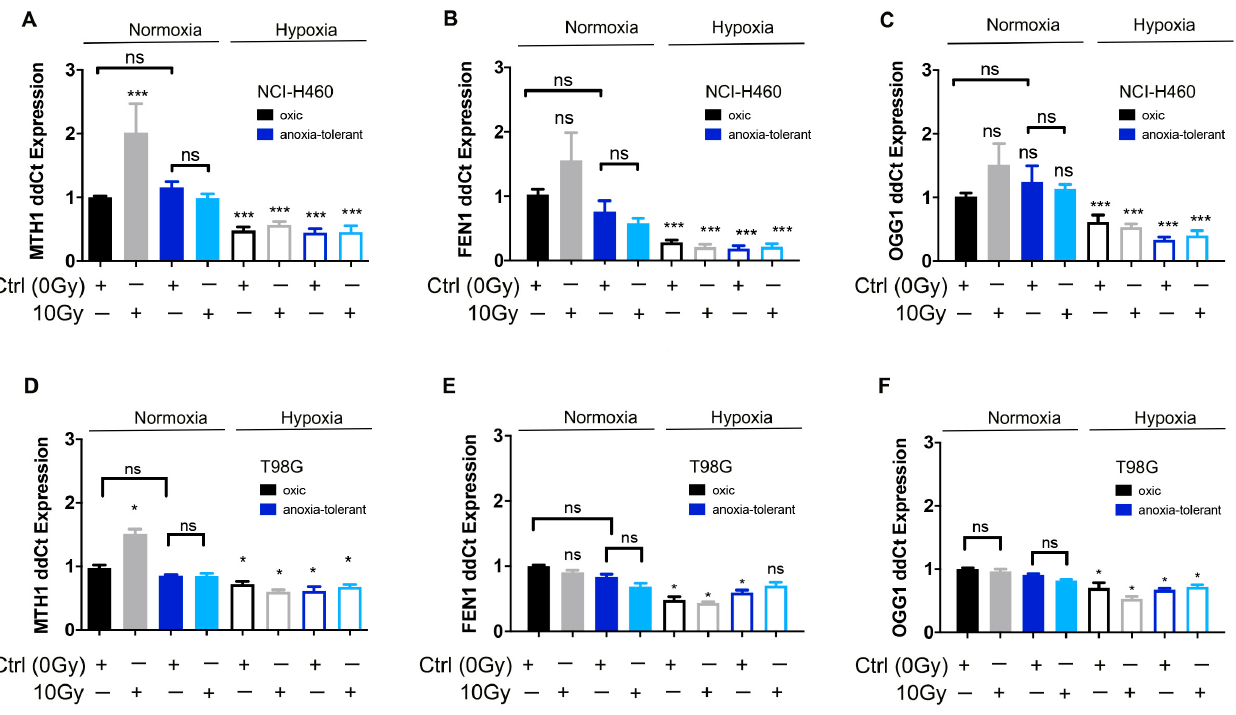
Figure 2. Ionizing radiation (IR) increases expression of MTH1 and BER genes in normoxia while acute hypoxia decreases their expression. Basal expression of MTH1 , OGG1 and FEN1 was determined in cancer cells with tolerance to chronic- cycling hypoxia (anoxia-tolerant) and respective oxic control cells 24 h after exposure to severe hypoxia and/or 10 Gy of IR. ( A ) qRT-PCR analysis of MTH1 expression normalized to oxic control in NCI-H460 cells. ( B ) qRT-PCR analysis of FEN1 expression normalized to oxic control in NCI-H460 cells. ( C ) qRT-PCR analysis of OGG1 expression normalized to oxic control in NCI-H460 cells. ( D ) qRT-PCR analysis of MTH1 expression normalized to oxic control in T98G cells. ( E ) qRT-PCR analysis of FEN1 expression normalized to oxic control in T98G cells. ( F ) qRT-PCR analysis of OGG1 expression normalized to oxic control in T98G cells. Mean values ± SEM are shown, n = 3 (ns: not significant, * p ≤ 0.05, *** p ≤ 0.001; t -test).